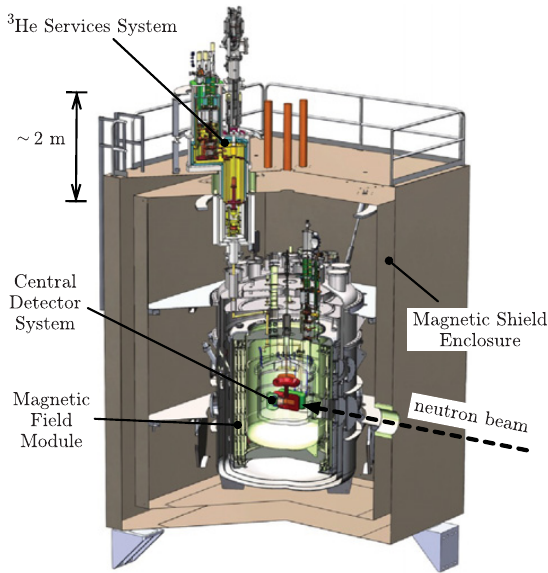
Figure 3. Design of the nEDM@SNS apparatus. Primary sub- systems, which are described in Sect. 3, are labeled. A magnified view of the Central Detector System is shown in Fig.